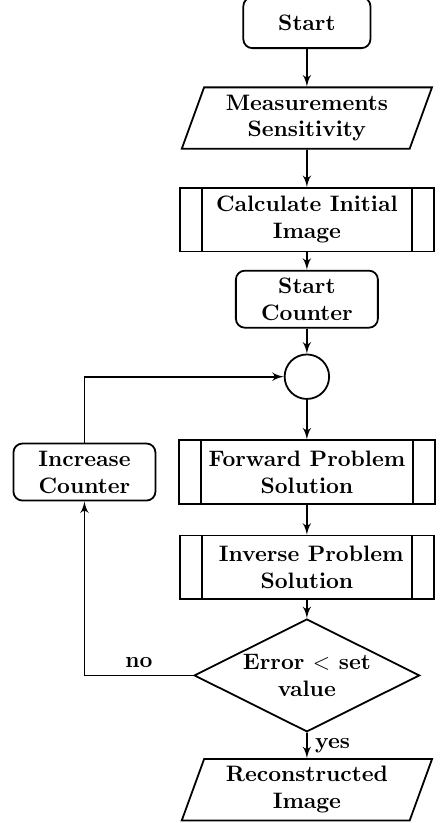
Figure 3. Nonlinear reconstruction algorithm in